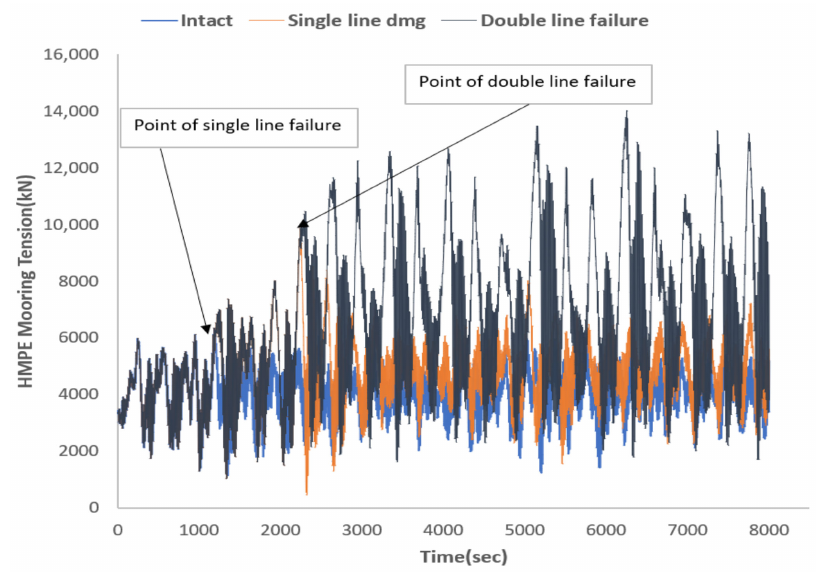
Figure 12. Comparison of HMPE representative mooring line (line 7) in intact and damaged